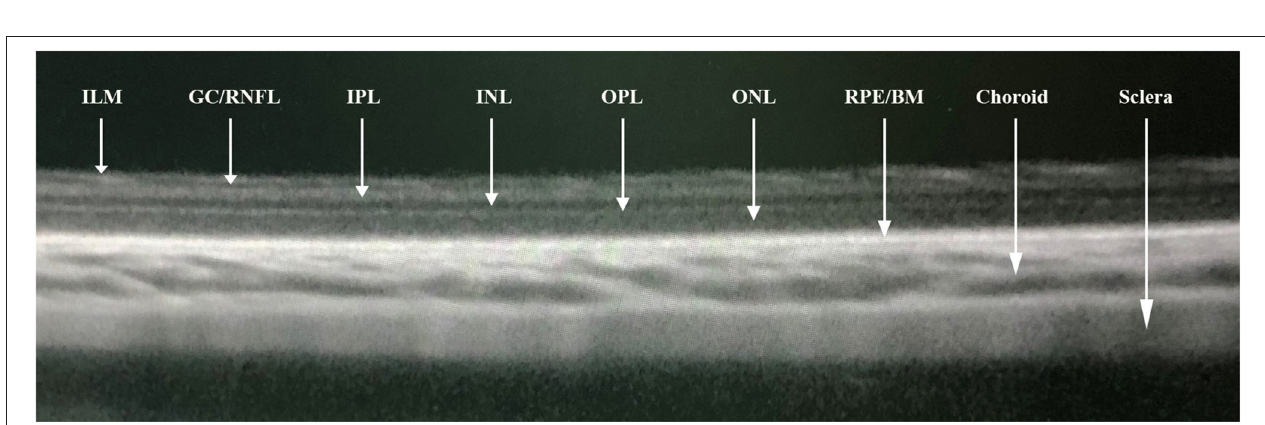
FIGURE 2 | Segmentations of optical coherence tomographic image (enhanced depth imaging mode) showing the internal limiting membrane (ILM), ganglion cell/retinal nerve fiber layer (GC/RNFL), inner plexiform layer (IPL), inner nuclear layer (INL), outer plexiform layer (OPL), outer nuclear layer (ONL), retinal pigment epithelial/Bruch’s membrane (RPE/BM), choroid, and